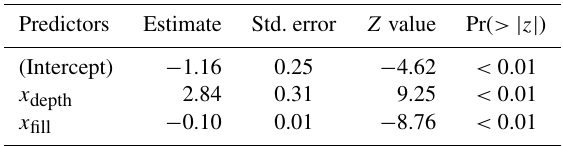
Table 1. Coefficients of logistic regression to predict if I PF > 4 . 7%. The term “Estimate” represents the increase in log-odds of a dam being classified as case (or success ) per unit increase in the value of the